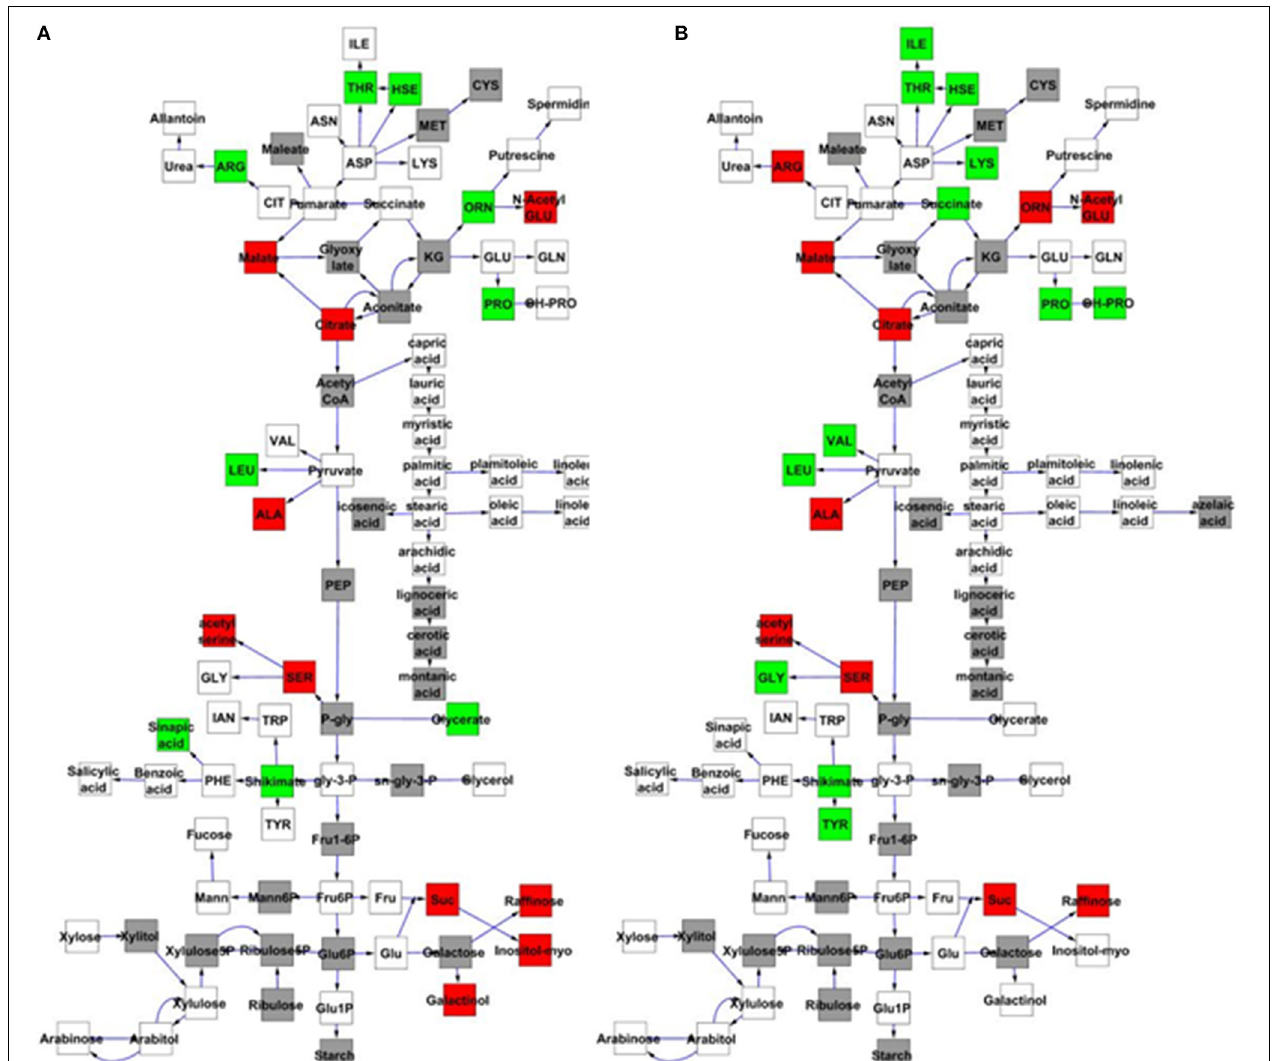
FIGURE 4 | MNM1 effects upon the metabolic network. Shown are the known primary metabolites that are altered at all timepoints by the mnm1-1 and mnm1-2 and overexpression genotypes in comparison to wildtype controls within the free-run experiment. The gray boxes show metabolites not measured in these experiments, white boxes are metabolites that had no significant difference, green boxes were up regulated in the respective MNM1 genotypes and red boxes were down-regulated in the respective MNM1 genotypes. Only metabolites